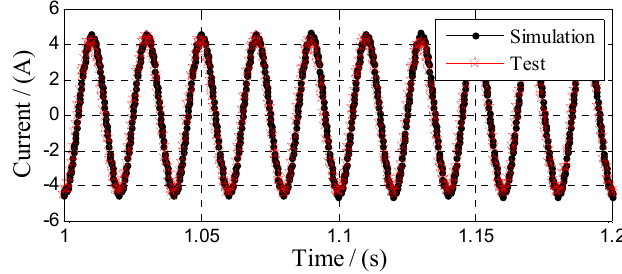
Figure 18. Simulation and experimental currents considering the magnetizing saturation.